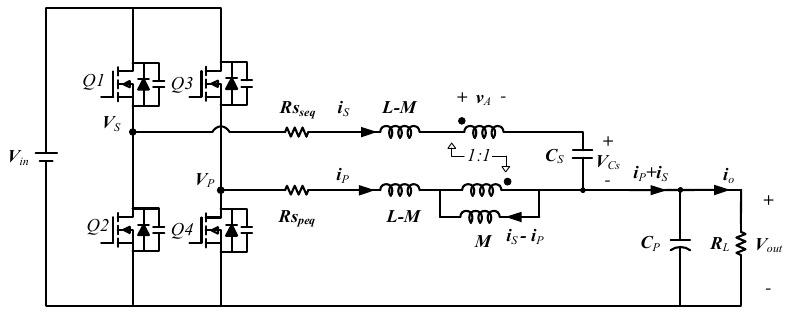
Figure 27. Implementation circuit diagram of a stacked buck converter in the form of coupled inductor. Table 2. Dead time modulation parameters. Symbols Parameter Names Symbols Specifications